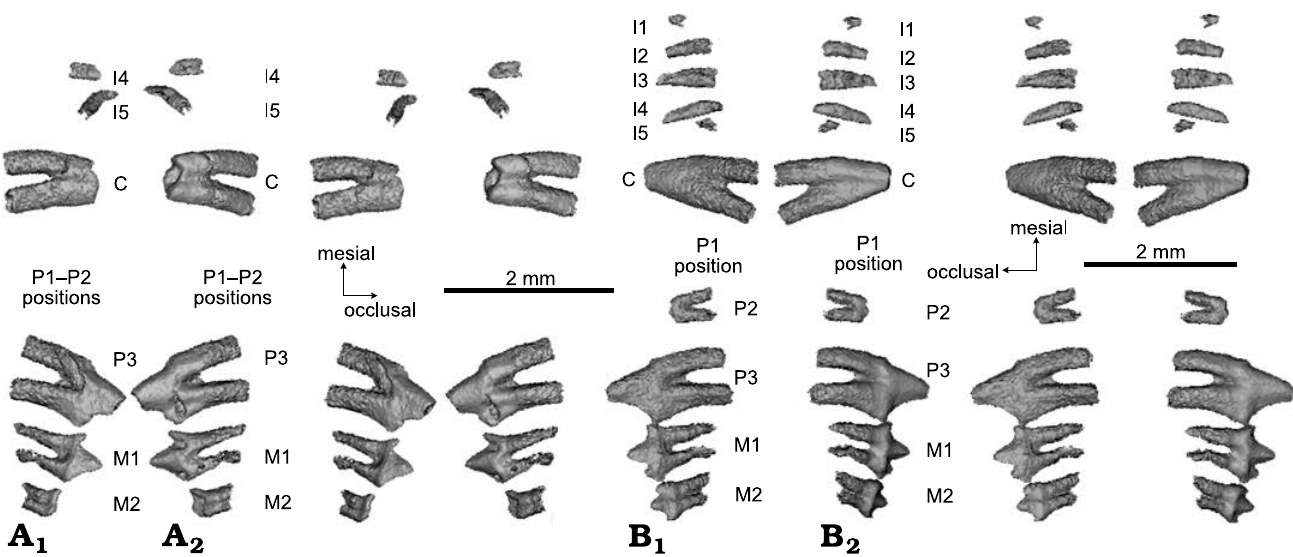
Fig. 7. CT rendering of mammaliaform Hadrocodium wui Luo, Crompton, and Sun, 2001 (holotype, IVPP 8275) from the Lower Lufeng Formation, Lower Jurassic of Yunnan, China. A . Left upper teeth (as preserved and virtually extracted from the upper jaws): incomplete incisors, canine, incomplete premolars and two molars in lingual (A 1 , stereopairs) and labial (A 2 , stereopairs) views. Left dentition has five incisor positions: two broken incisors, plus three additional incisors represented by alveoli visible on the fossil skull (but not visualized in teeth). Of the three premolars, P1 is not preserved, but P1 position is represented by a plugged alveolus on right side (not visualized here). P2 is preserved on right side, but is lost and represented only by empty alveoli on the left. P3 is intact on both sides. B . Right upper teeth: five upper incisors (I1 and I5 broken), canine, two premolars, two molars in lingual (B 1 , stereopairs) and labial (B 2 , stereopairs) views.